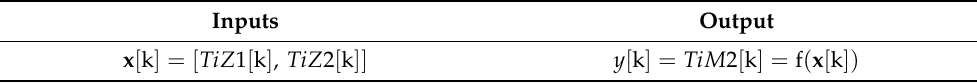
Table 4. Input–output pair of Experiment 2.